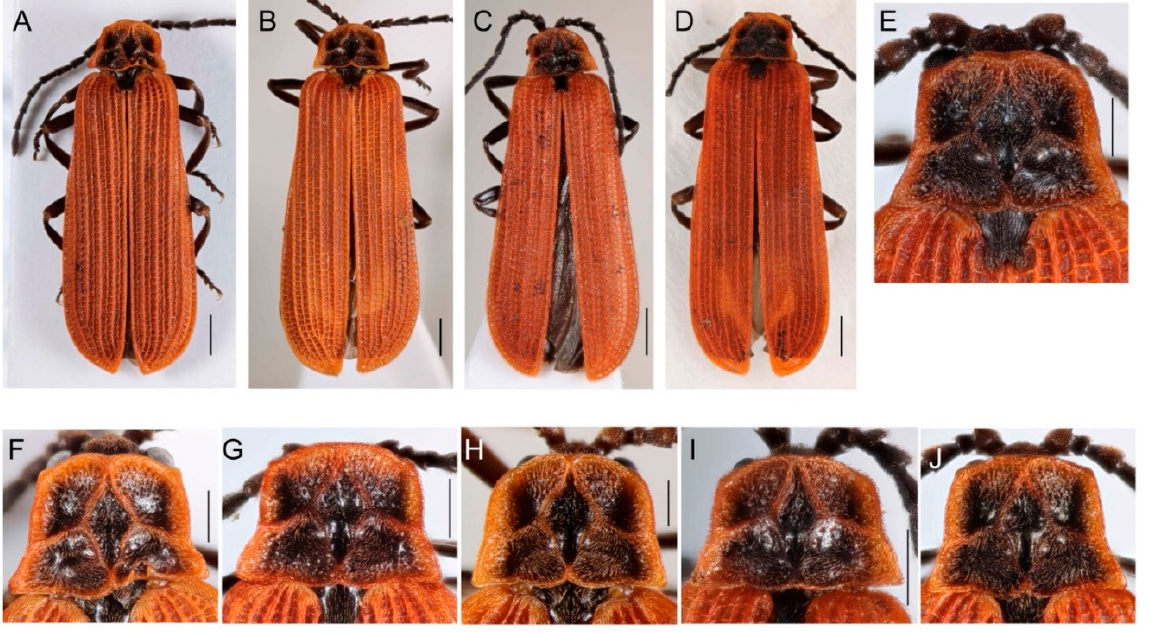
Figure 2. ( A , B , F – H ) Dictyoptera aurora and ( C – E , I , J ) D. coccinata . ( A – G ) General appearance; ( E – J ) Pronotum. Scales: 1 mm ( A – D ), 0.5 mm ( E – J